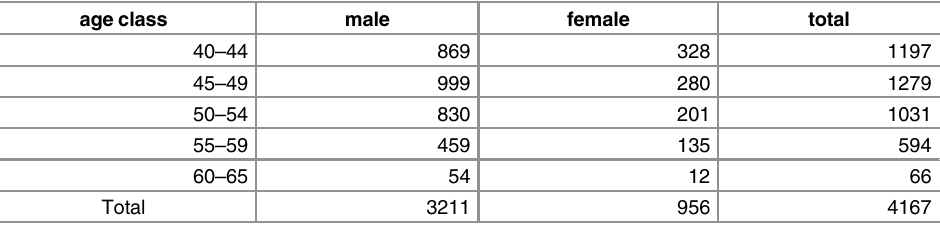
Table 3. Age and sex